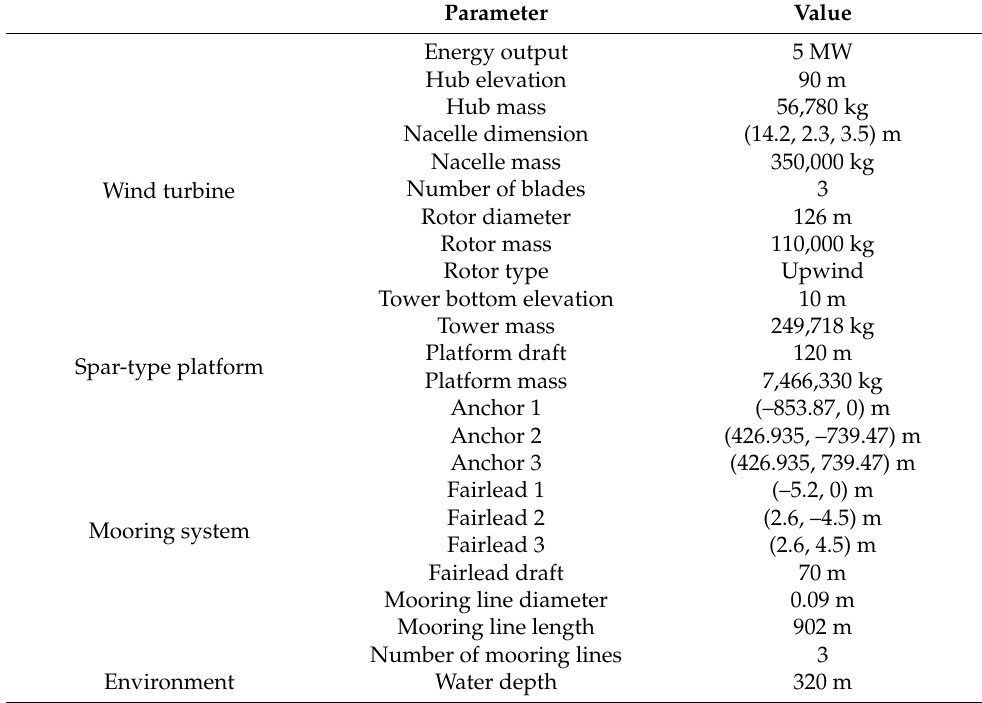
Table 1. Structural parameters of OC3-Hywind Spar-type 5 MW offshore floating wind turbine.